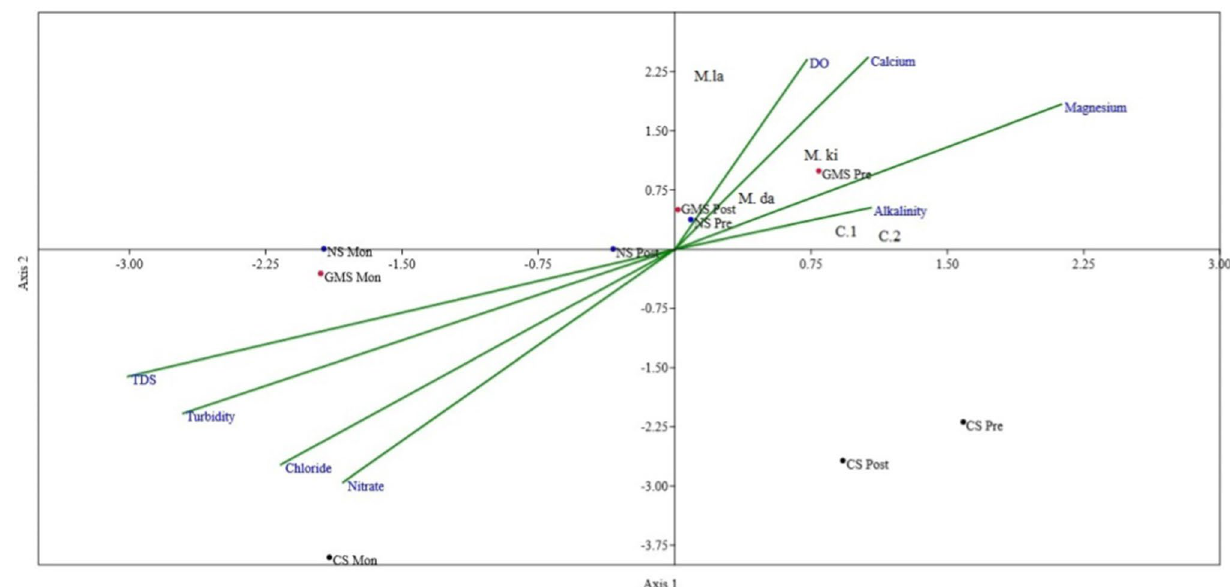
Fig. 7 Canonical correspondence analysis biplot between physicochemical parameters and abundance of prawn species at different